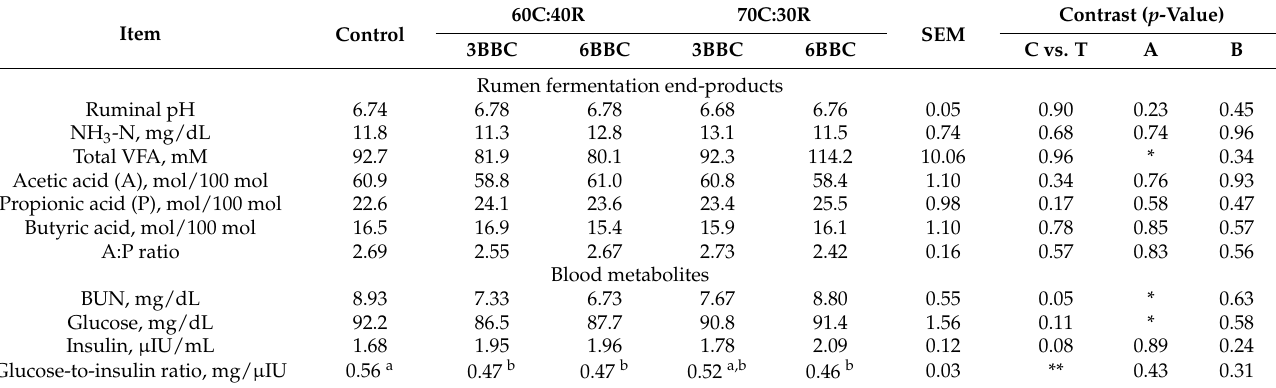
Table 3. Rumen parameters and blood metabolites in beef cattle fed with different concentrate-to-roughage ratio diets and different levels of BBC